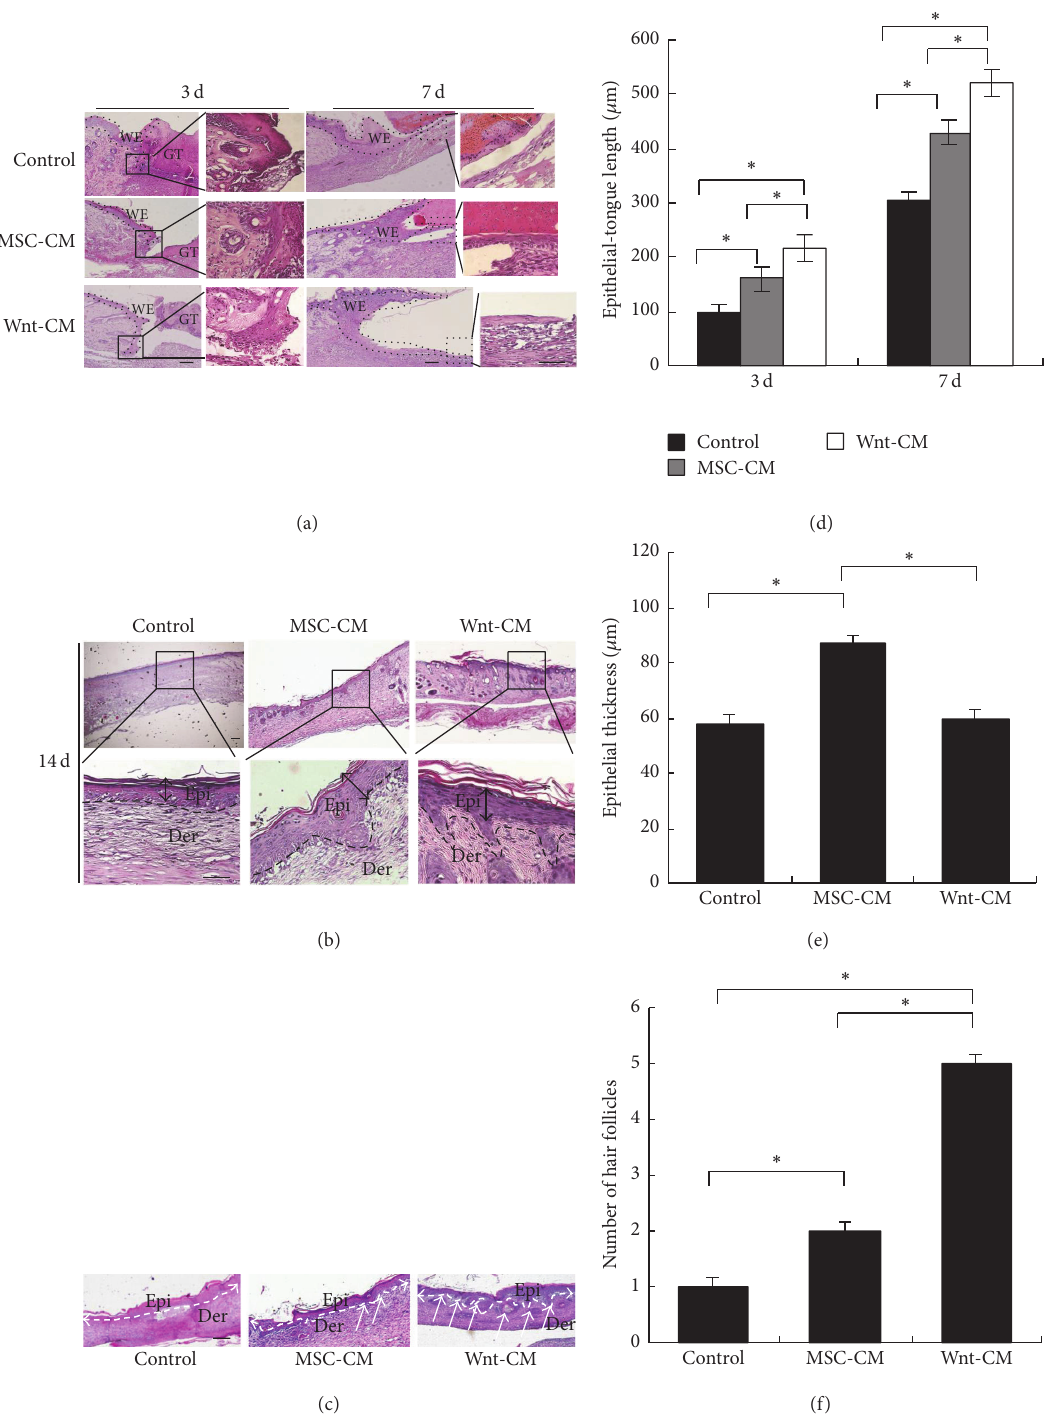
Figure 5: Histomorphological analysis of reepidermalization during skin healing in mice. (a, d) Histological analysis of wounds showed significantly increased length of the wound epithelial tongue in mice of treatment group Wnt-CM, as compared to the MSC-CM and DMEM treatment groups on postinjury days 3 and 5. (b, e) The epidermis thickness of the wounds treated with Wnt-CM, MSC-CM, or DMEM in mice on postinjury day 14. (c) The number of regeneration hair follicles in a wound. The data are presented as mean ± SEM, 𝑛 = 3 ; ∗∗ 𝑃 < 0.01 . The arrow indicates hair follicle regeneration. GT, granulation tissue; WE, wound epithelium; Epi, epidermis; Der, dermis. The scale bar in panels (a), (b), and (c) is 100 𝜇